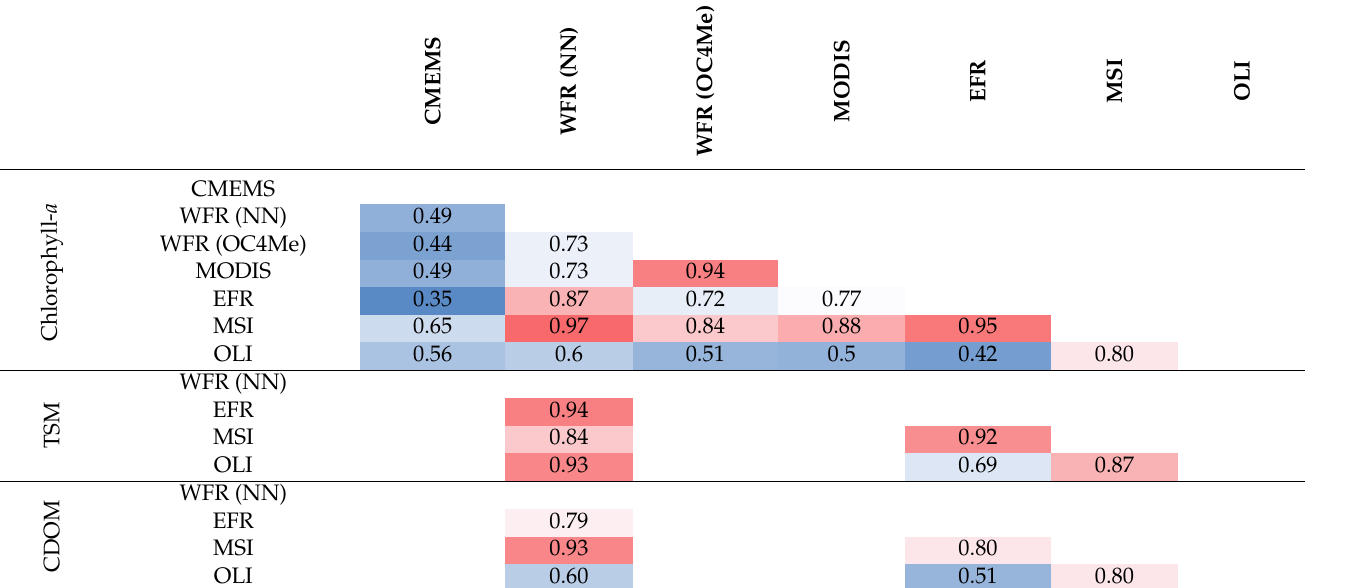
Table 4. Pearson’s correlation coefficients of the coastal water quality parameters estimated from EFR, MSI, and OLI against the reference standard CMEMS, WFR, and MODIS parameters ( n = 275).